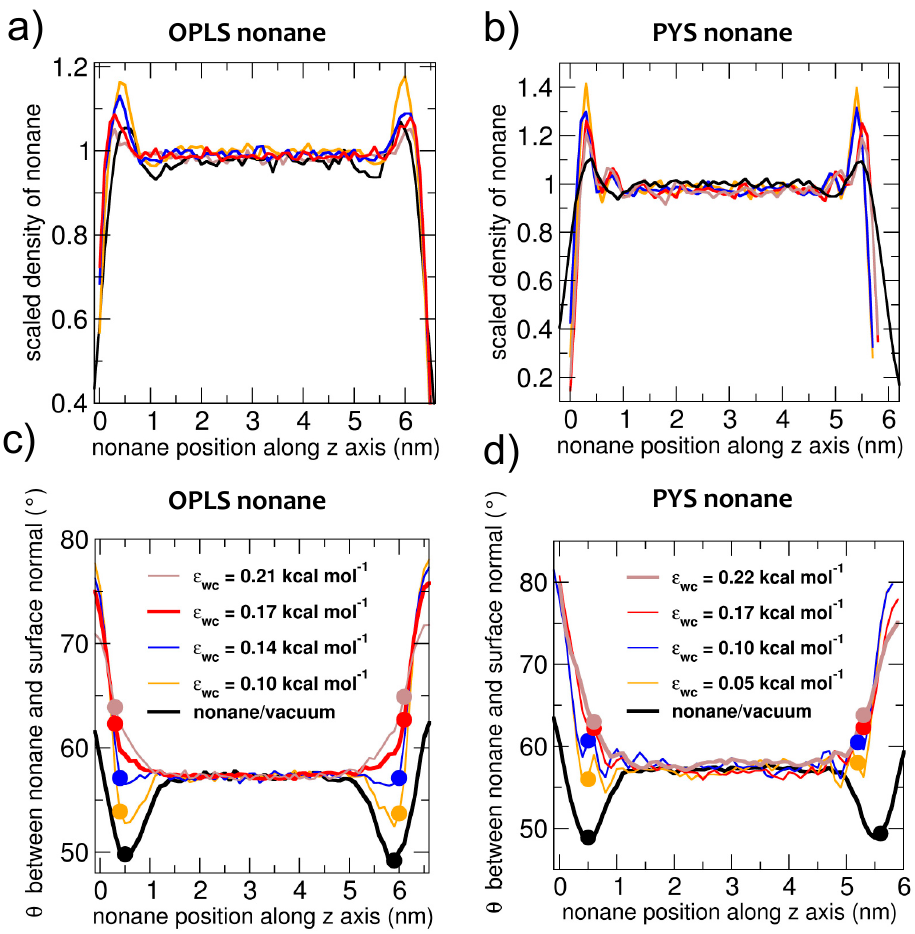
Figure 1. Profiles of the density ( a – b panels) and average orientation ( c – d panels) of liquid nonane in contact with vacuum and water, for which the strength ε wc of the water–carbon interaction is tuned. The ordering of the liquid by the interface is short-ranged, about the length of a nonane molecule, and turns from leaning parallel to the surface to leaning more perpendicularly to the surface on decreasing the strength of the coupling between alkane and the other fluid phase (water or vacuum). The parameters that reproduce the experimental water–nonane surface tension are shown with thick lines: brown for PYS ( ε wc = 0.22 kcal·mol − 1 ) and red for OPLS ( ε wc = 0.17 kcal·mol − 1 ). The densities are presented scaled with respect to the bulk values; the orientations are computed with respect to the surface normal, as shown in Figure 2. Densities and orientations are computed at 310 K for OPLS nonane and at 240 K for PYS nonane. Solid circles signal the average orientation θ measured 0.5 nm from the Gibbs dividing surface.